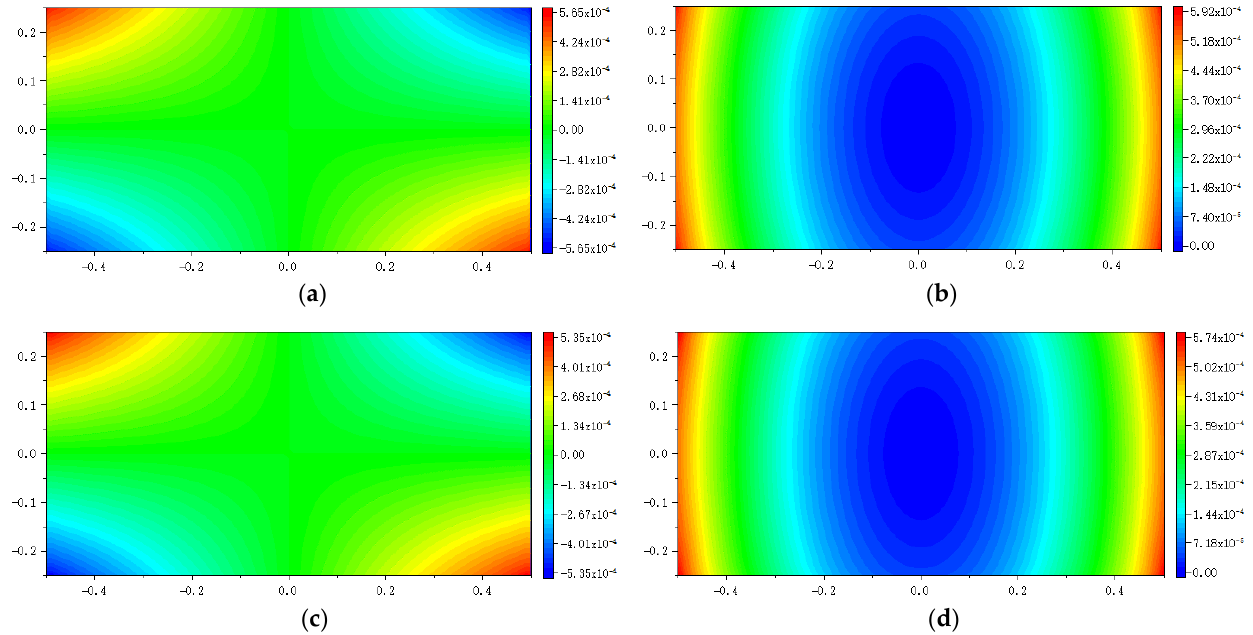
Figure 16. The displacement along the vertical line x = 0 when the plate bending: ( a ) u x along x = 0; ( b ) u y along x = 0.